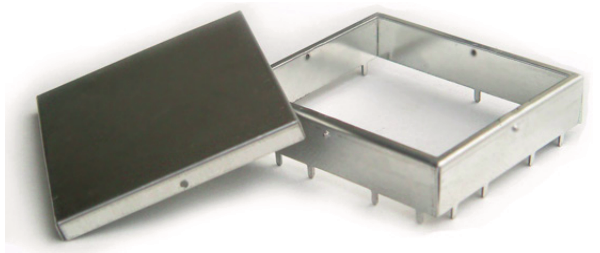
Figure 6. Electromagnetic shield for radio